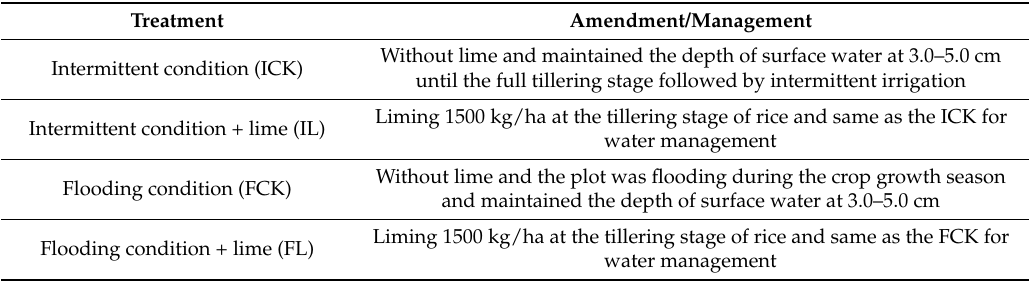
Table 1. Experimental